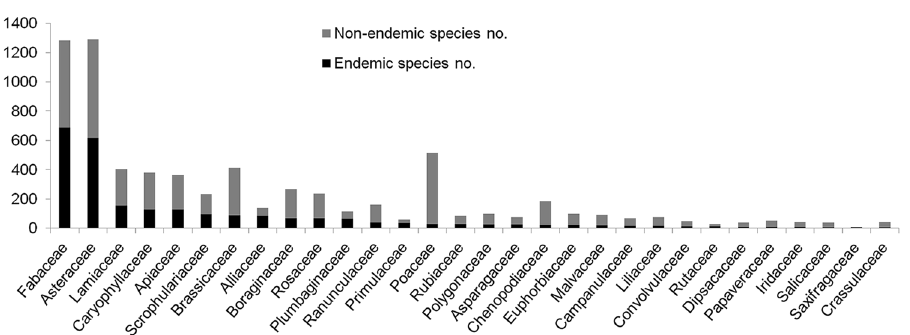
Figure 2. Number of endemic and non-endemic species in the 30 most endemic-rich families of the Iranian vascular flora (sorted by number of endemic